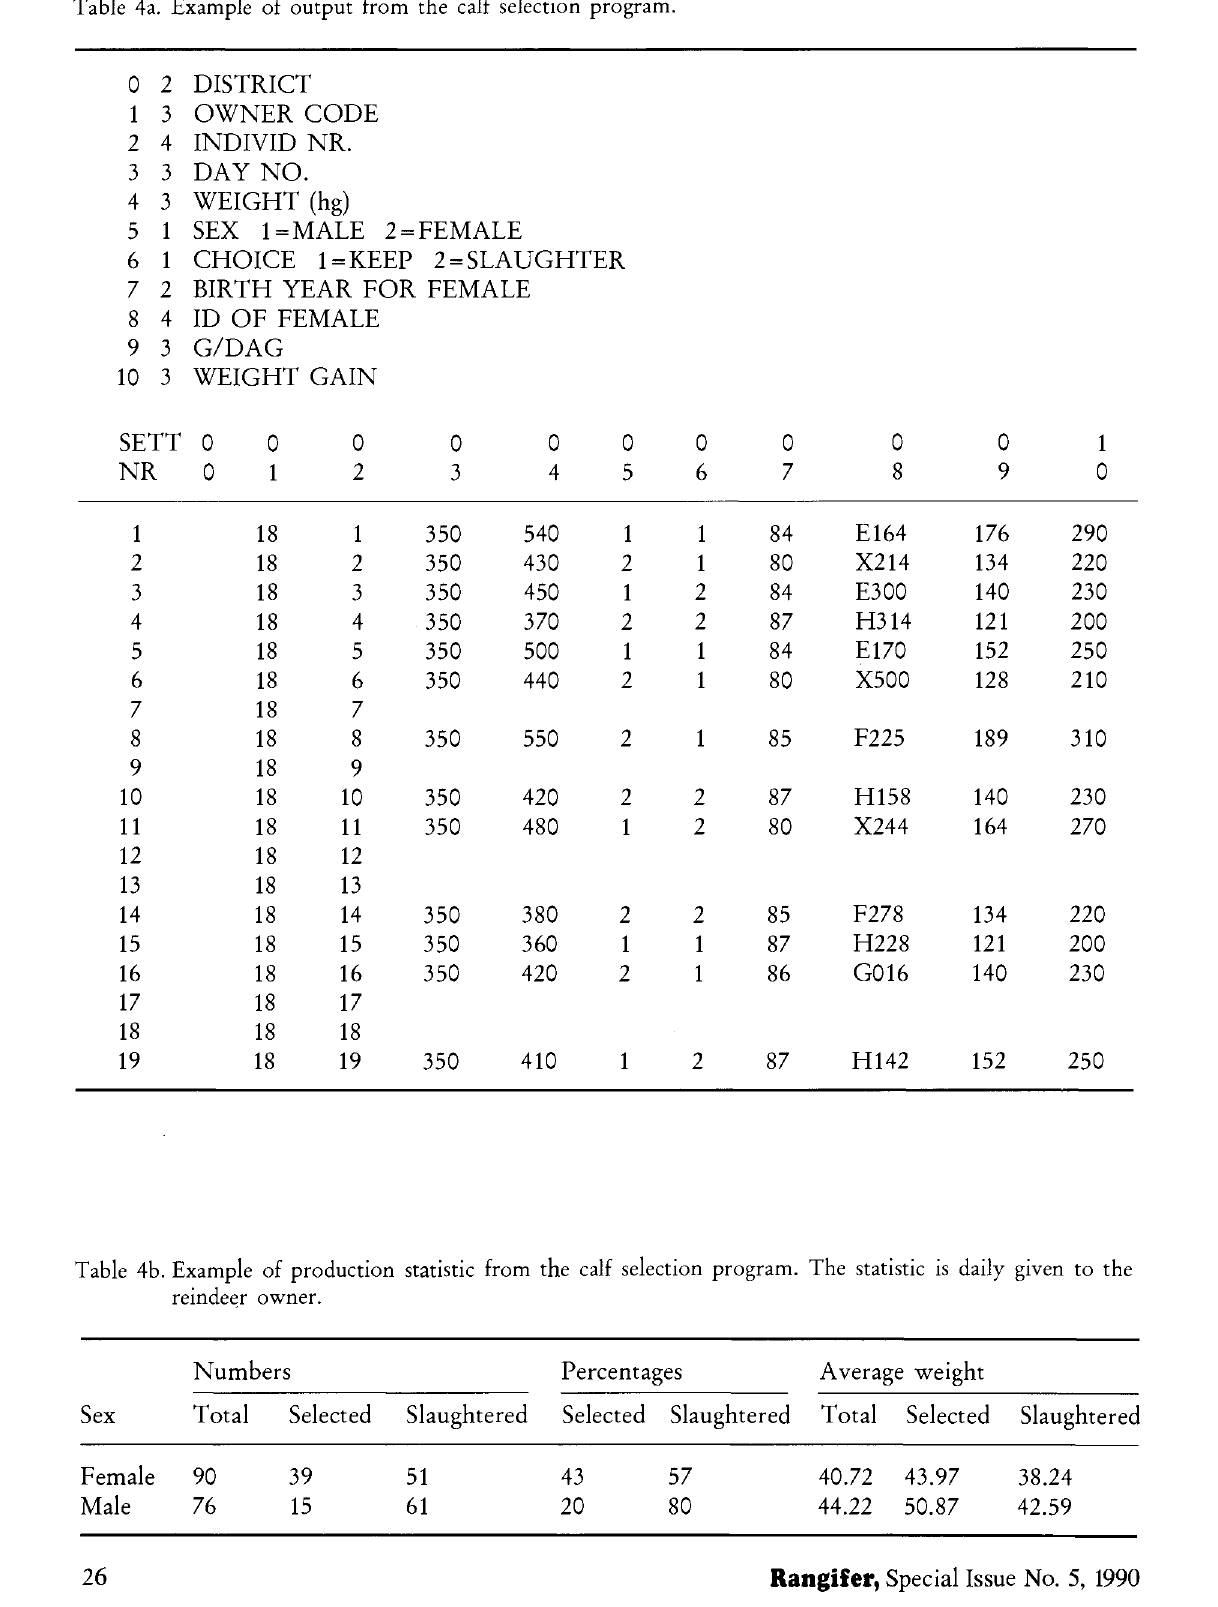
Table 4a. Example of output from the calf selection program.